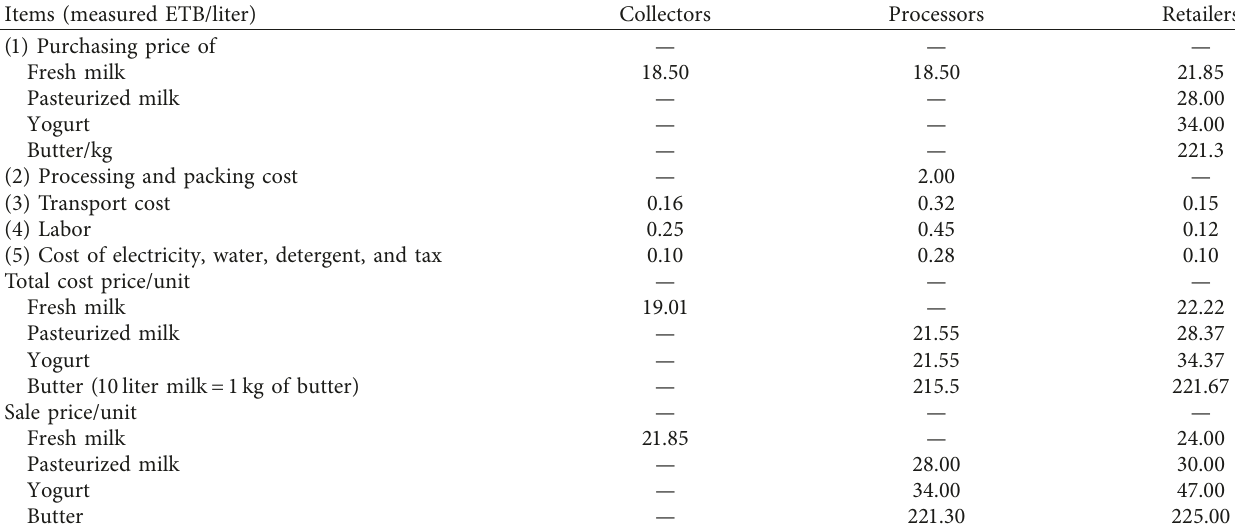
Table 6: Average cost and selling price of milk and milk